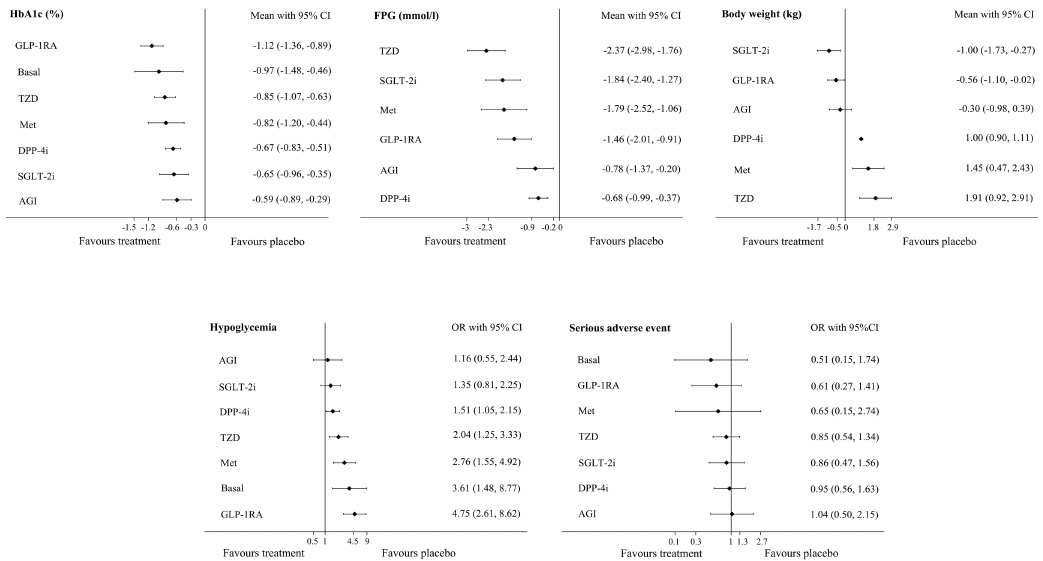
Fig 3. Differences versus placebo in efficacy and safety outcomes. Note: HbA1c, glycated hemoglobin; FPG, fasting plasma glucose; SGLT-2i, sodium-glucose co-transporter-2 inhibitor; DPP-4i, dipeptidyl peptidase-4 inhibitor; GLP-1RA, glucagon-like peptide-1 receptor agonist; TZD, thiazolidinedione; Met, metformin; AGI, α -glucosidase inhibitor; Basal, basal (long-acting) insulin.